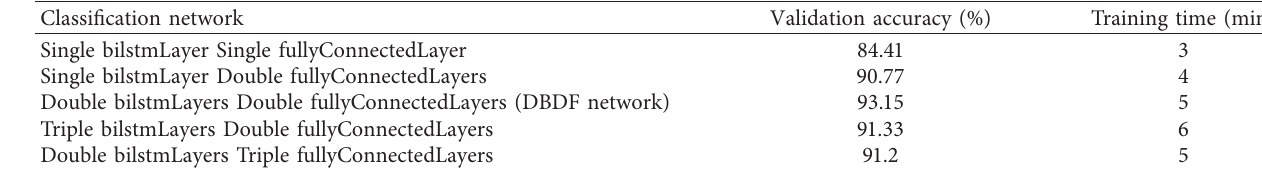
Table 5: Comparison of different classification networks.